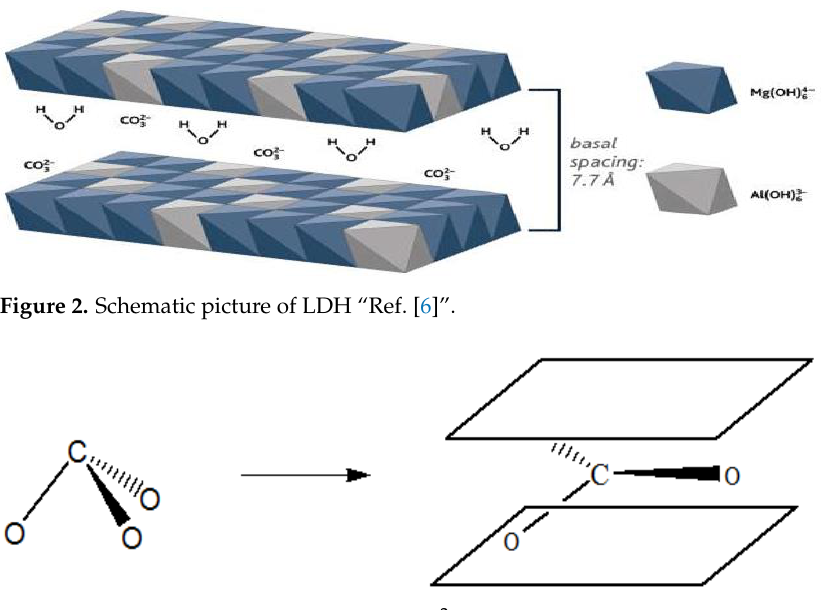
32 − ions in the inner space of LDHs “Ref. Figure 3. Plane-parallel arrangement of CO 3 2− ions in the inner space of LDHs “Ref.[6]” . Figure 3. Plane-parallel arrangement of CO Figure 3. Plane-parallel arrangement of CO 3 2− ions in the inner space of LDHs “Ref.[6]” . Figure 3. Plane-parallel arrangement of CO 3 2− ions in the inner space of LDHs “Ref.[6]” .